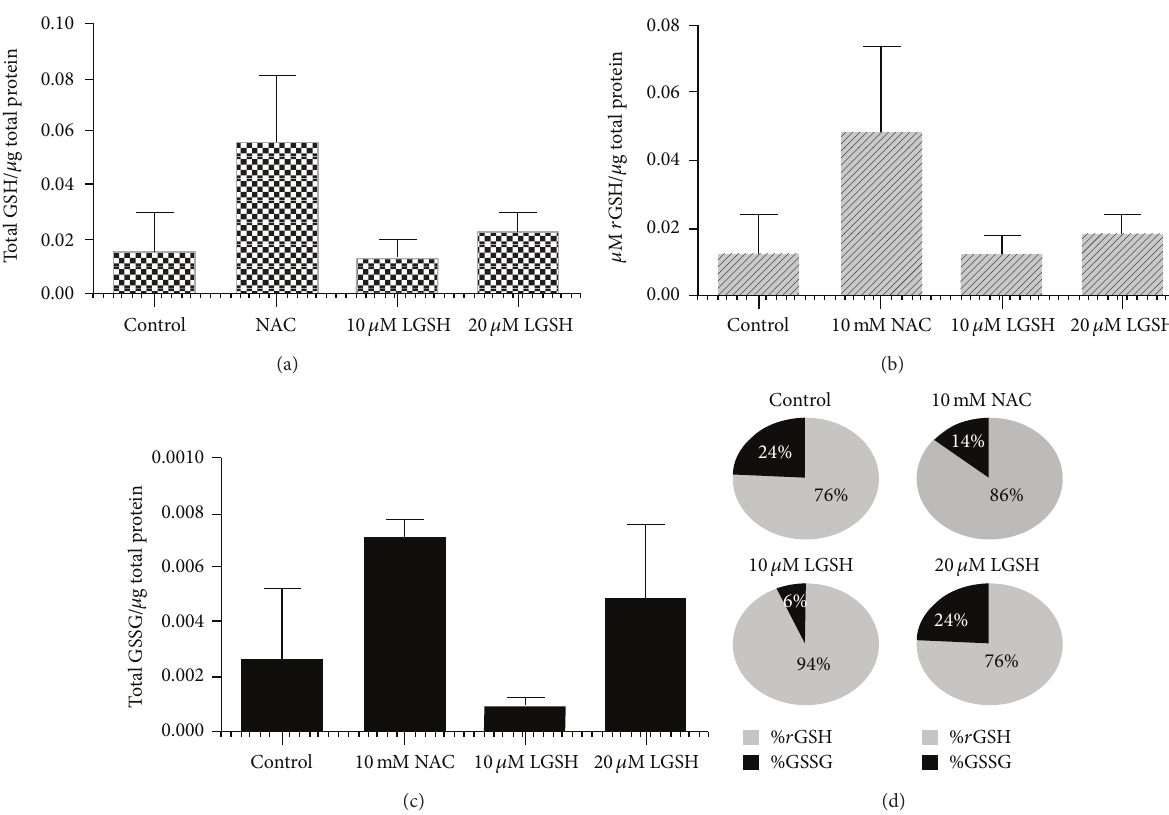
Figure 2: GSH measurements in uninfected neutrophils cultured in the presence and absence of NAC or L-GSH ( 𝑛 = 5 ). GSH levels were measured in isolated neutrophils from healthy subjects that were treated with GSH-enhancing agents such as NAC and L-GSH, by spectrophotometry using an assay kit. Briefly, neutrophils (3 × 10 5 ) were lysed at 24 hours after treatment with ice cold 5% 5-sulfosalicylic acid dehydrate solution. Supernatants collected after centrifugation were analyzed for total GSH (a) and GSSG (c) as per manufacturer’s instructions. r GSH was calculated by subtracting measured GSSG concentrations from the measured total GSH concentrations (b). All GSH measurements were normalized with total protein levels. Proteins in the cell lysates of neutrophils were measured by Bradford’s method using a Coomassie protein assay reagent. (d) illustrates ratio of r GSH to GSSG expressed as percentage of total GSH in neutrophil lysates. Graph shows mean ± standard